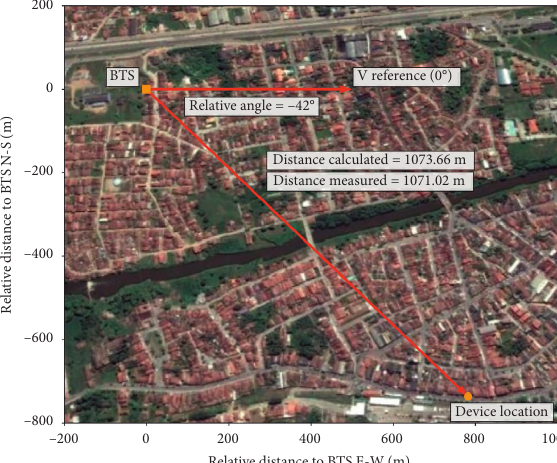
Figure 11: Satellite view of the test BTS and device location (by Google Earth) showing the angle and distance measured and evaluated by the system.